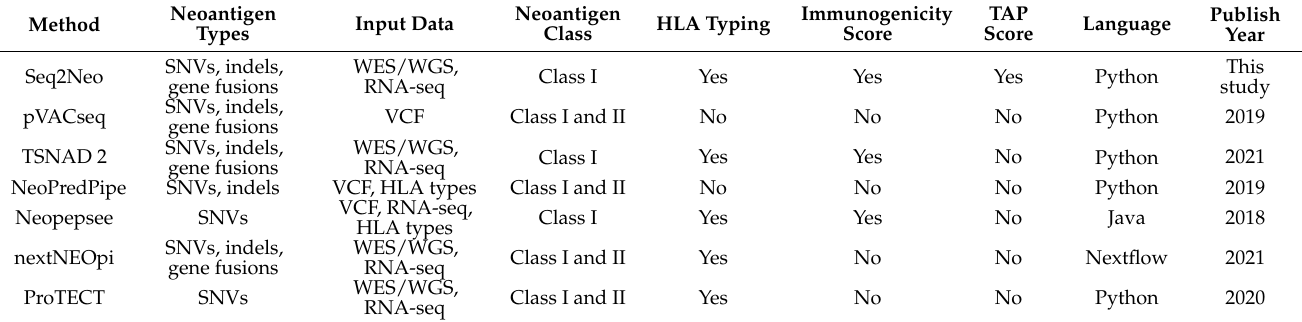
Table 1. Representative tools for predicting neoantigens that have been published in recent years. The neoantigen type, input data, neoantigen class, HLA typing, immunogenicity score, TAP score and programming language that were used are